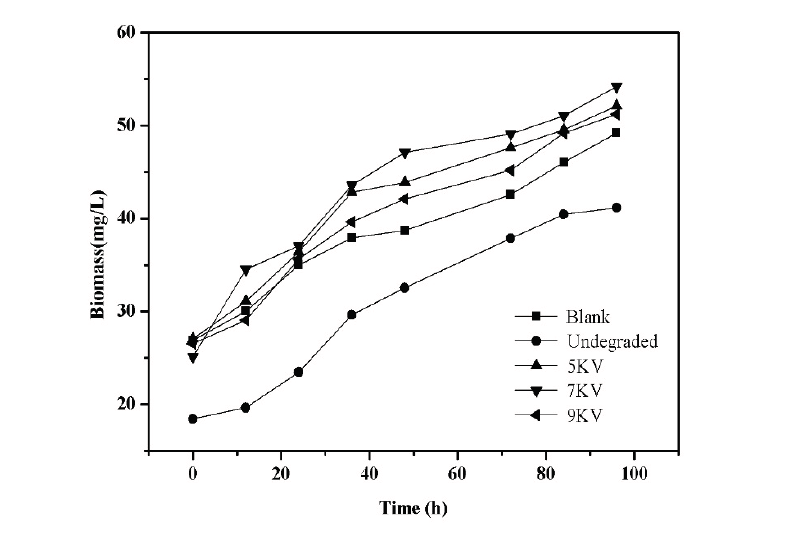
Figure 11. Influence of by-products on the growth of